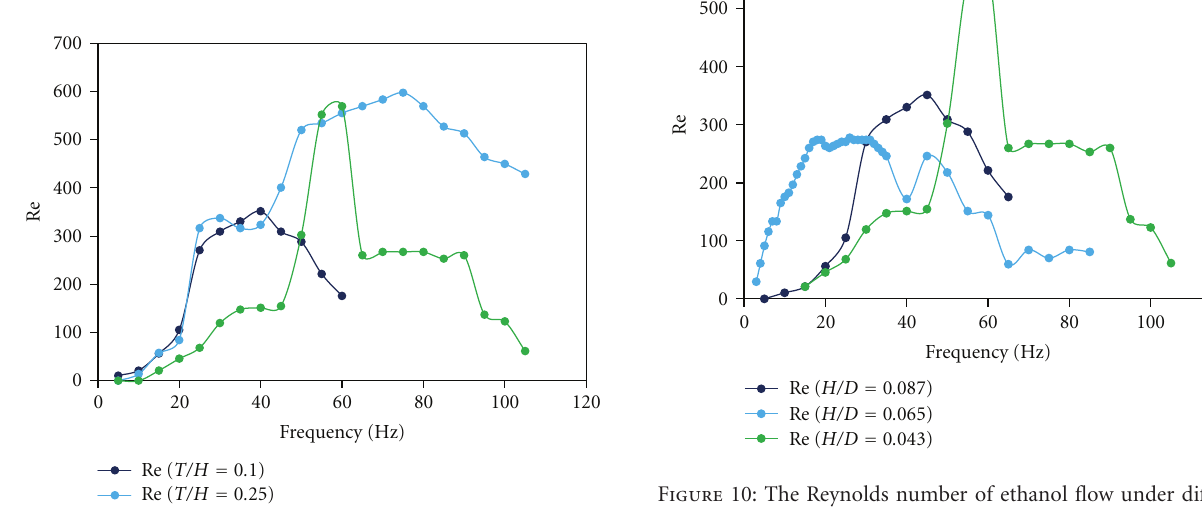
Figure 7: Measured flow rate under di ff erent frequency with di ff er- ent valve thickness. (Case D).